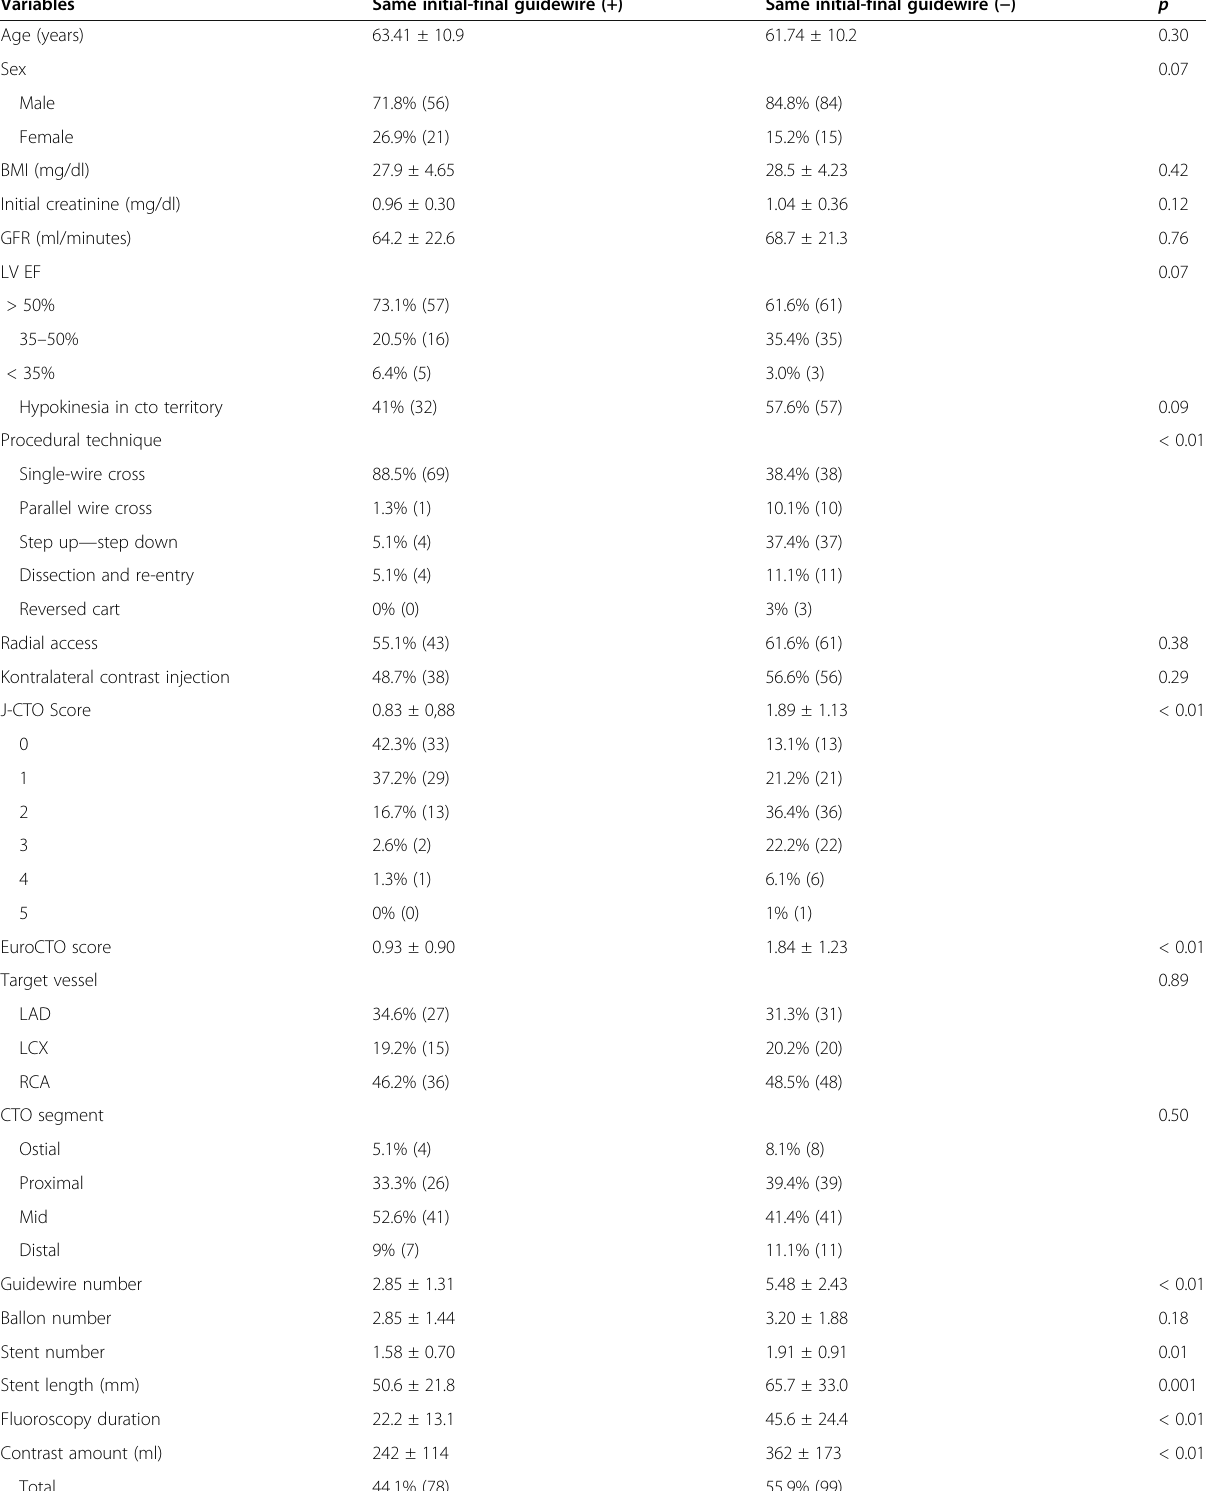
Table 3 Clinical and angiographic predictors of first-choice guidewire and it ’ s crossability through the CTO